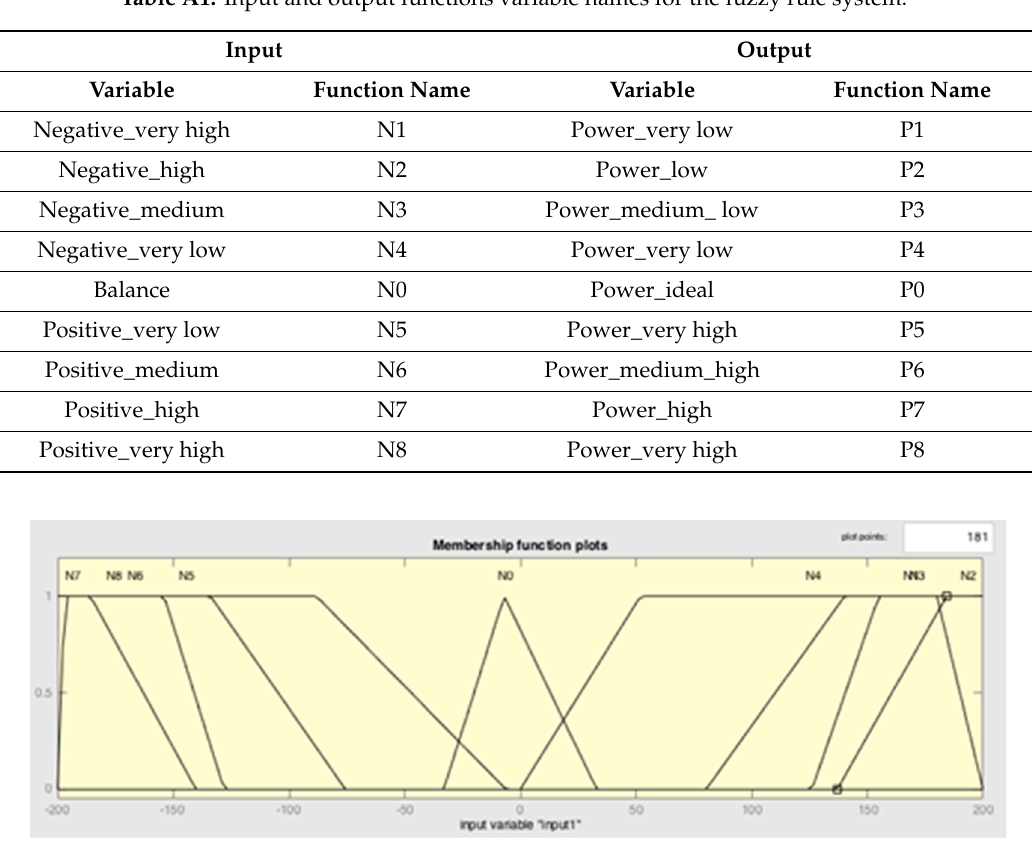
Table A1. Input and output functions variable names for the fuzzy rule system.